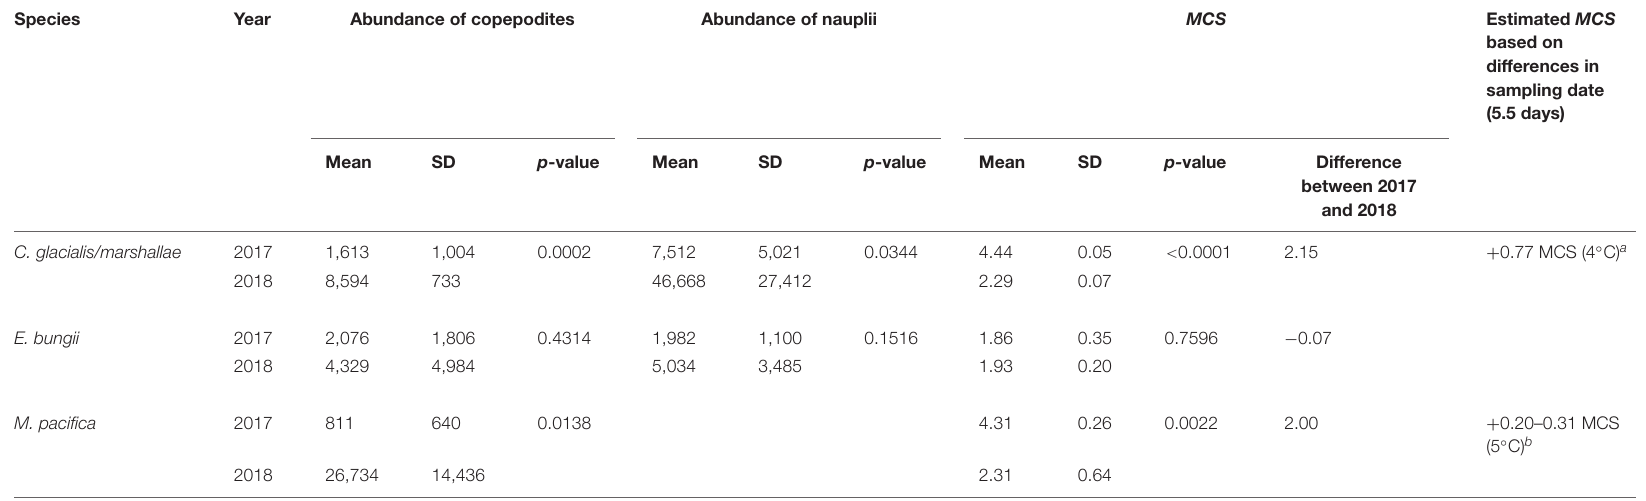
TABLE 4 | Result of the Mann–Whitney U test on mean and standard deviation of copepodite abundance, nauplii abundance, and MCS of the dominant large copepods in group E identified via Bray–Curtis similarity analysis based on zooplankton abundance (cf. Figure 4 ) in the northern Bering Sea during July of 2017 and 2018. Species Year Abundance of